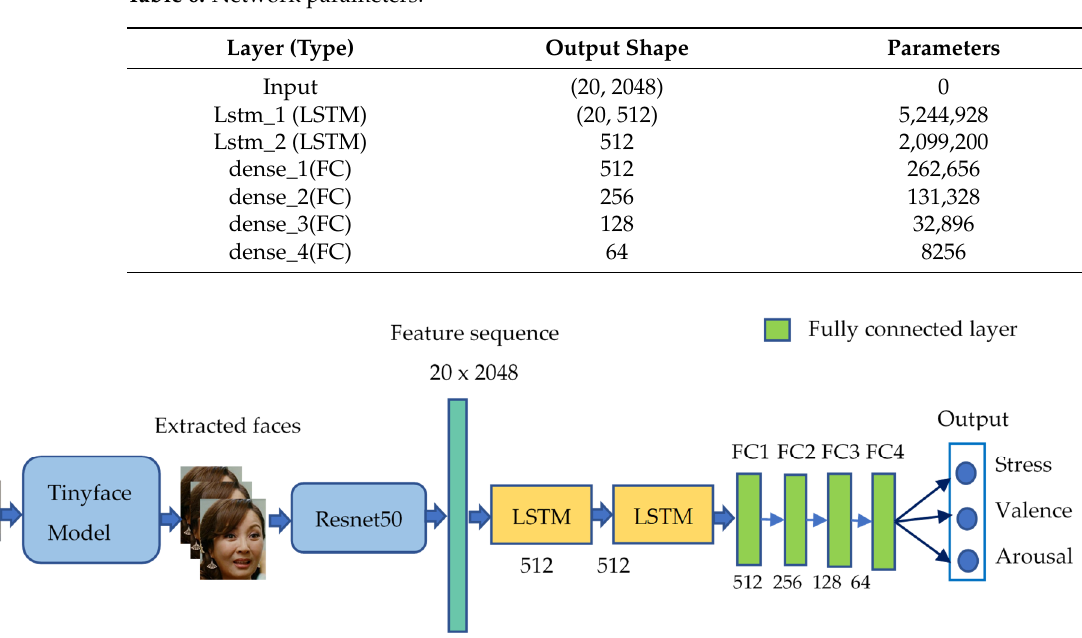
Figure 7. Architecture of the baseline model for stress, valence, and arousal recognition.